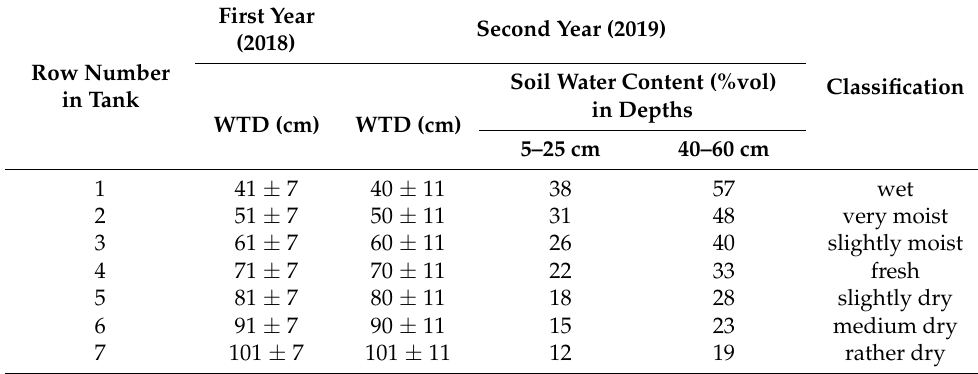
Table 1. Soil water conditions depending on the treatments. Row number in tank is counted from the bottom up (Figure 2). Water table distance (WTD) is given as mean ± standard deviation for both years separately. Soil depth was 90 cm. Soil water content was measured weekly only in the second growing season (year 2019) at three positions in the tanks (see Figure 2). Given values for each row were calculated by the models described in Figure